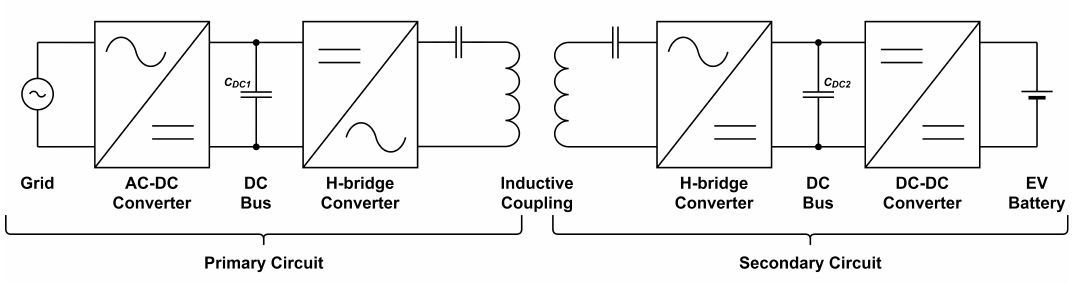
Figure 1. General scheme of the proposed IPT bidirectional system connected to the grid.